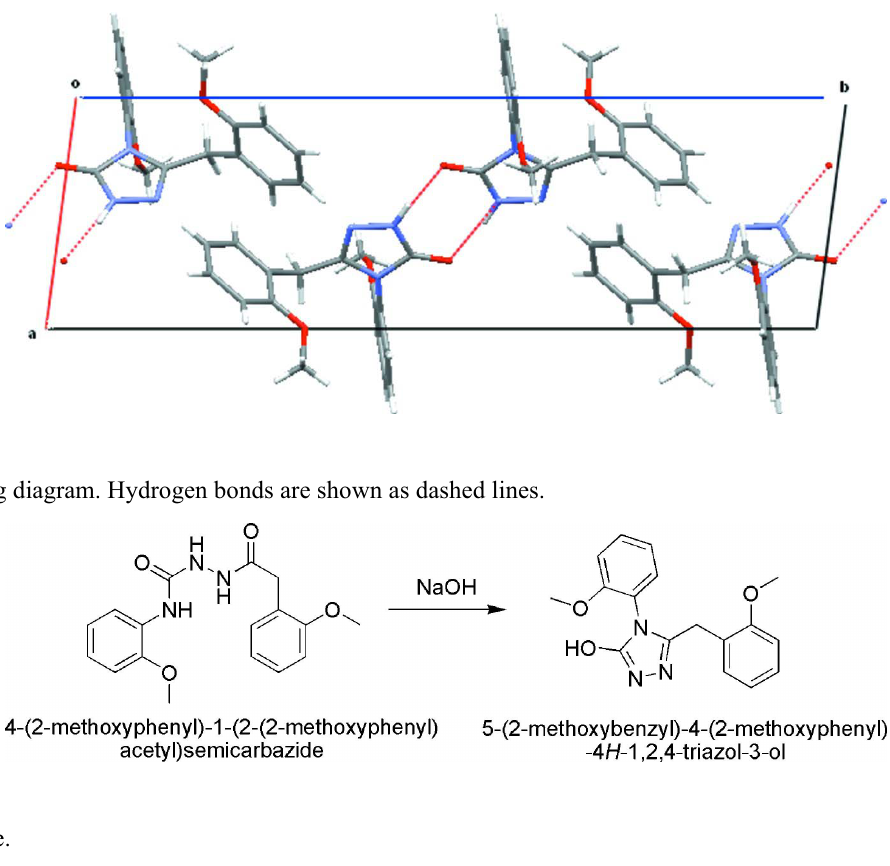
Figure 1 The molecular structure of the title molecule, with the atom-numbering scheme. Displacement ellipsoids are drawn at the 50% probability level.